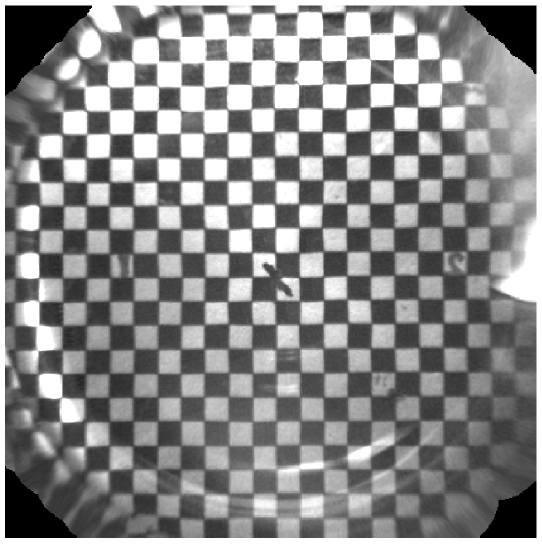
Figure A2. Recorded target image after